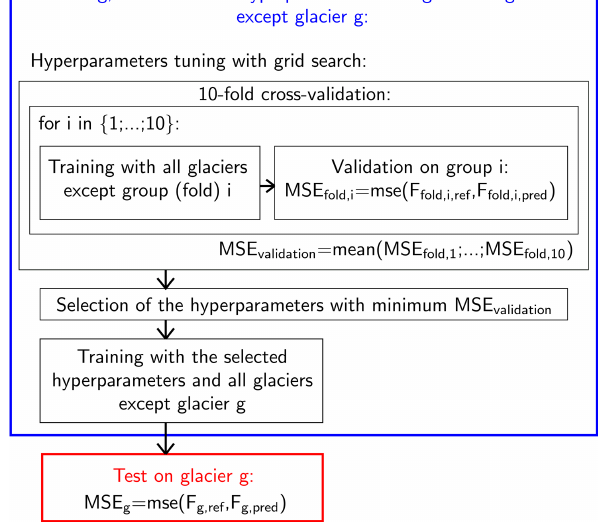
Figure 2. Training, cross-validation with hyperparameter selection and test scheme for the site-independent GBR model. F dB , ref is the reference adjustment factor (Eq. 2), and F dB , pred is the adjustment factor predicted by the GBR model.